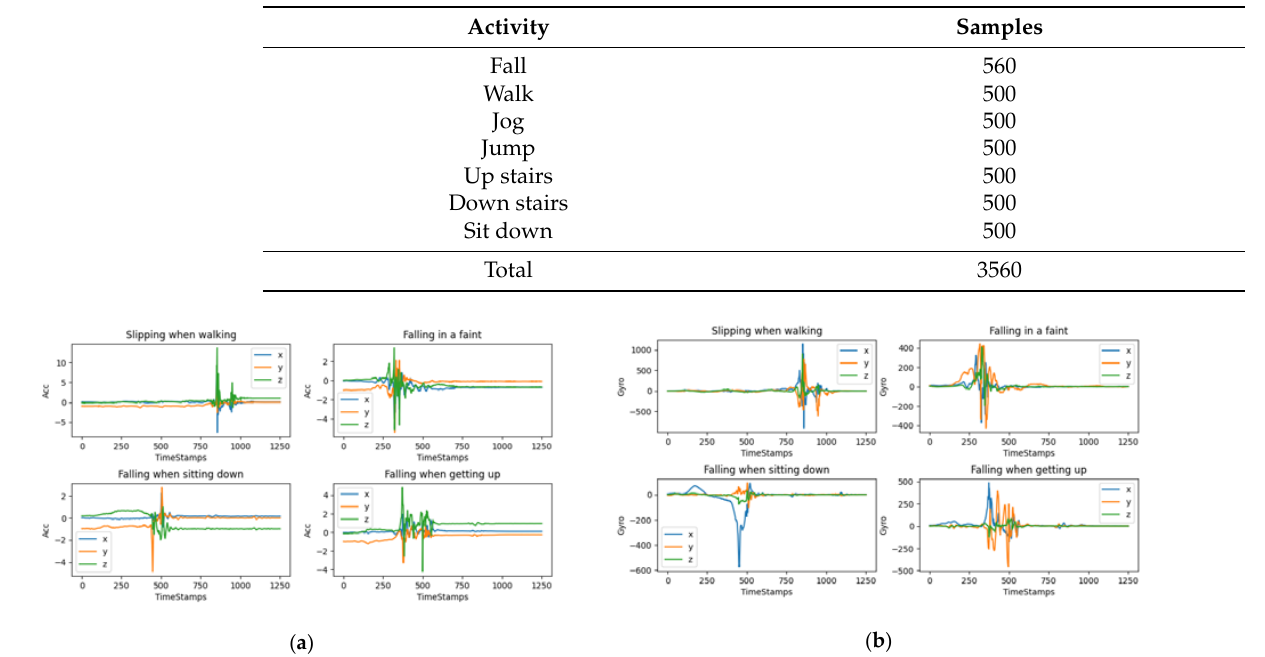
Table 2. Number of data collection samples.